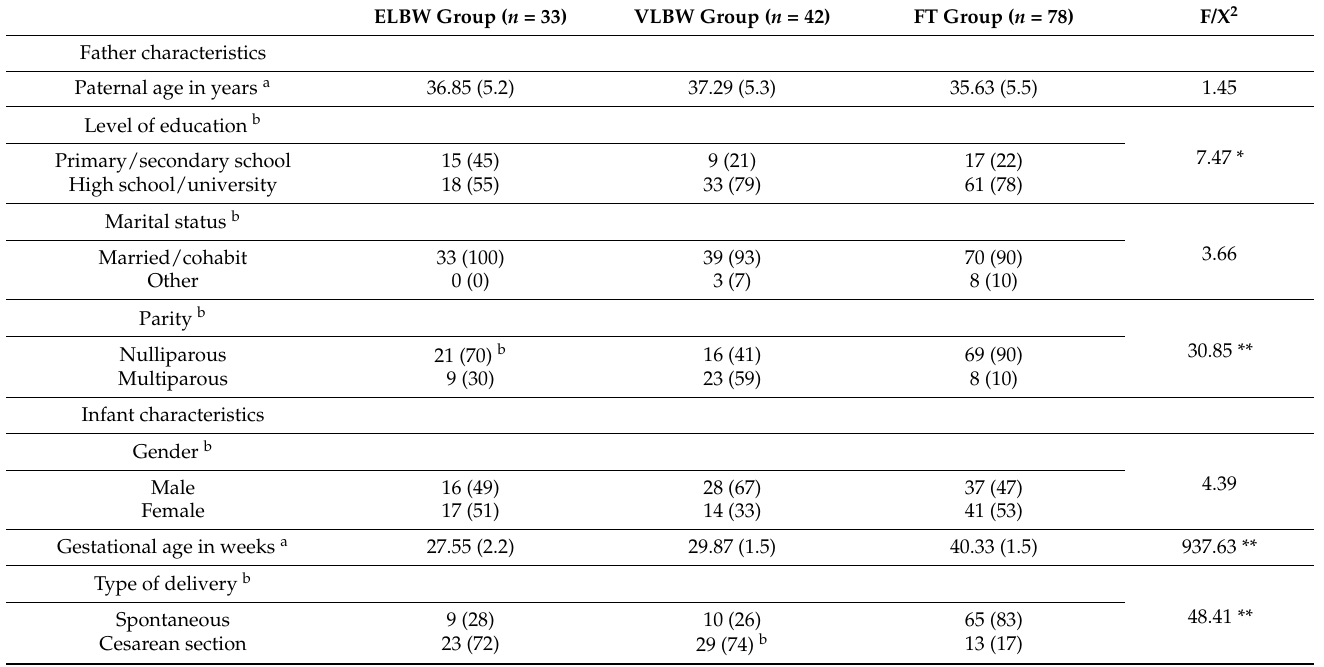
Table 1. Sociodemographic and clinical characteristics of father–infant